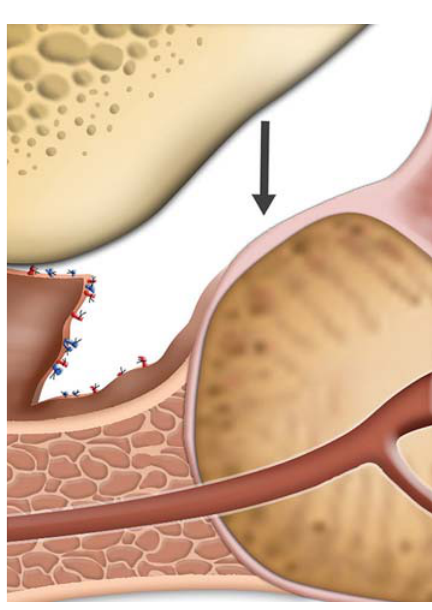
Figure 1 – Clamping and cutting of dorsal vein complex. Figure 2 – Clamping and cutting of dorsal vein complex. Arrow shows placement of back bleeding control